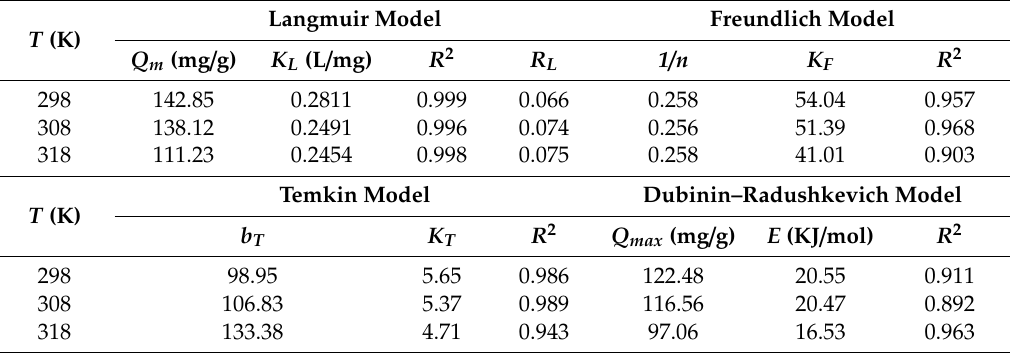
Table 3. Adsorption isotherm model